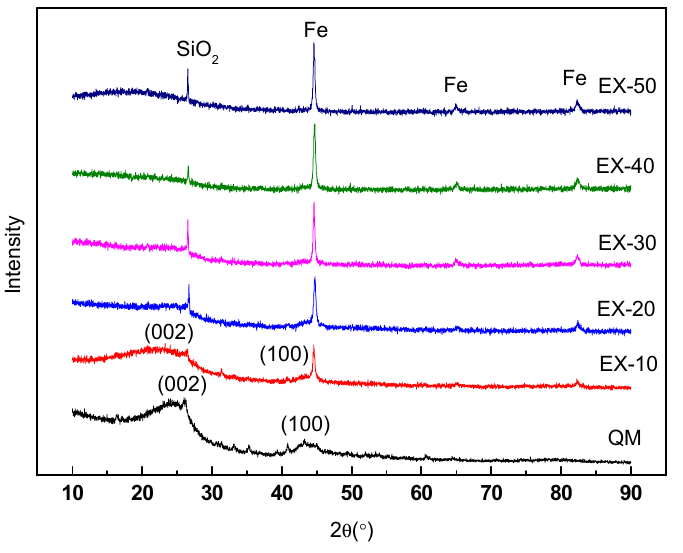
Figure 9. XRD of ferro-coke with different amounts of iron ore.